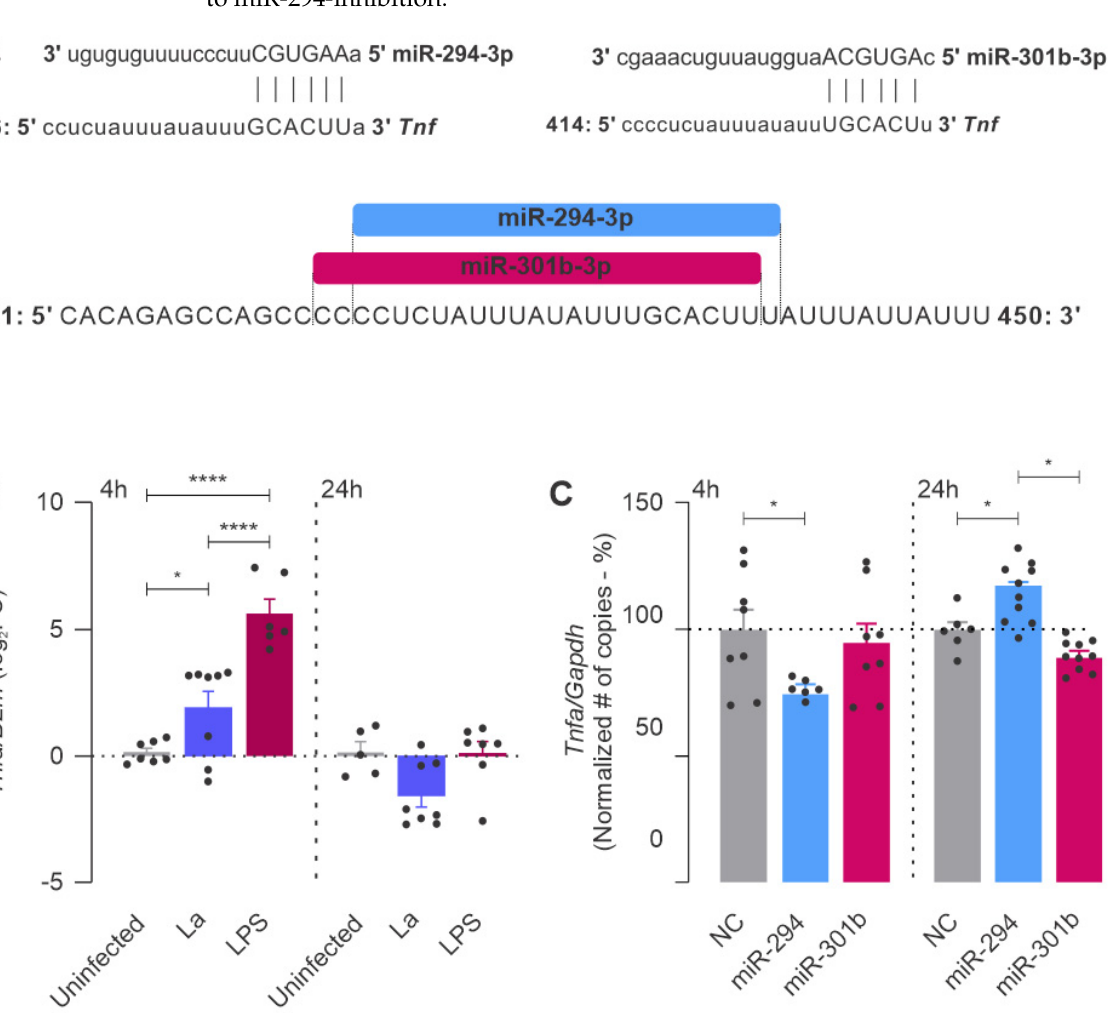
Figure 5. Tnfa is an miR-294 and miR-301b target. ( A ) In silico binding site prediction of miR-294 and miR-301b in the Tnfa 3 ′ UTR. ( B ) Basal levels of Tnfa after L. amazonensis infection or LPS stimulation. ( C ) Quantification of the infection’s ability to produce Tnfa after miRNA inhibition. Statistics: Each dot represents a biological replicate from three independent ex- periments. Mixed-effects analysis, post hoc test: Sidak’s multiple comparisons. p -values: *, p ≤ 0.05; ****, p ≤ 0.0001.